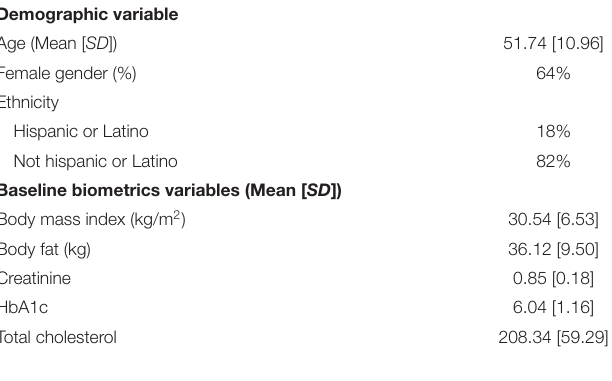
TABLE 1 | Demographic and biometric profile of the intervention sample ( n = 39).